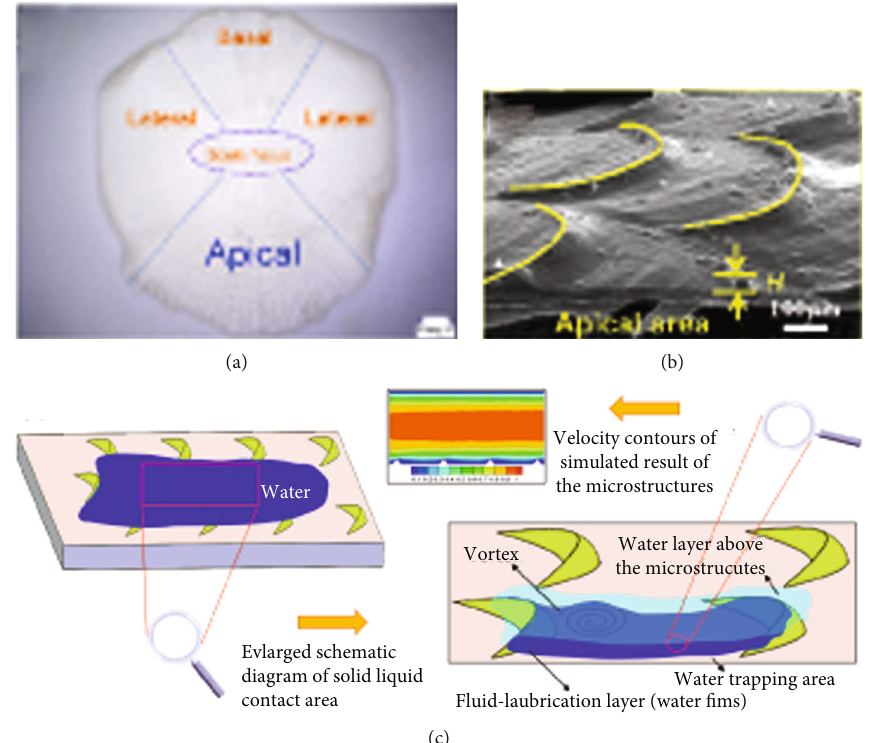
Figure 22: Schematic diagram of water capture defects in (a) geometric structure, (b) crescent-shaped structure, and (c) crescent-shaped microstructure of fi sh scales [109].